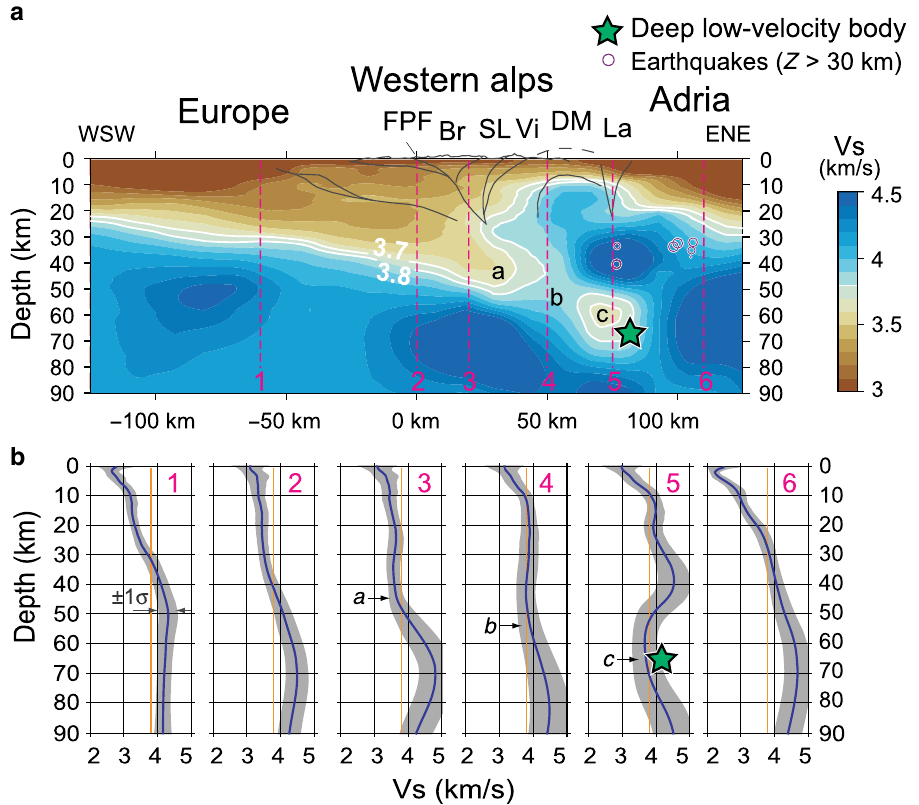
Fig. 2 Shear-wave velocity model across the Western Alps. a Cross-section showing the absolute Vs in the 0 – 90-km depth range (see location in Fig. 1b). The white lines indicate the 3.7 and 3.8 km s − 1 contours. The green star marks the deep – low-velocity body. Earthquake foci (depth > 30 km) in a 40-km- wide swath parallel to the pro fi le are plotted as purple circles. Letters a – c indicate regions of the model discussed in the text. The main crustal features (black lines) after Zhao et al. 15 and Malusà et al. 17 (acronyms as in Fig. 1b). b Depth – velocity pro fi les (±1 σ ) beneath six typical sites along the transect (see location in Fig. 1b and panel a ). The orange vertical line is the 3.8 km s − 1